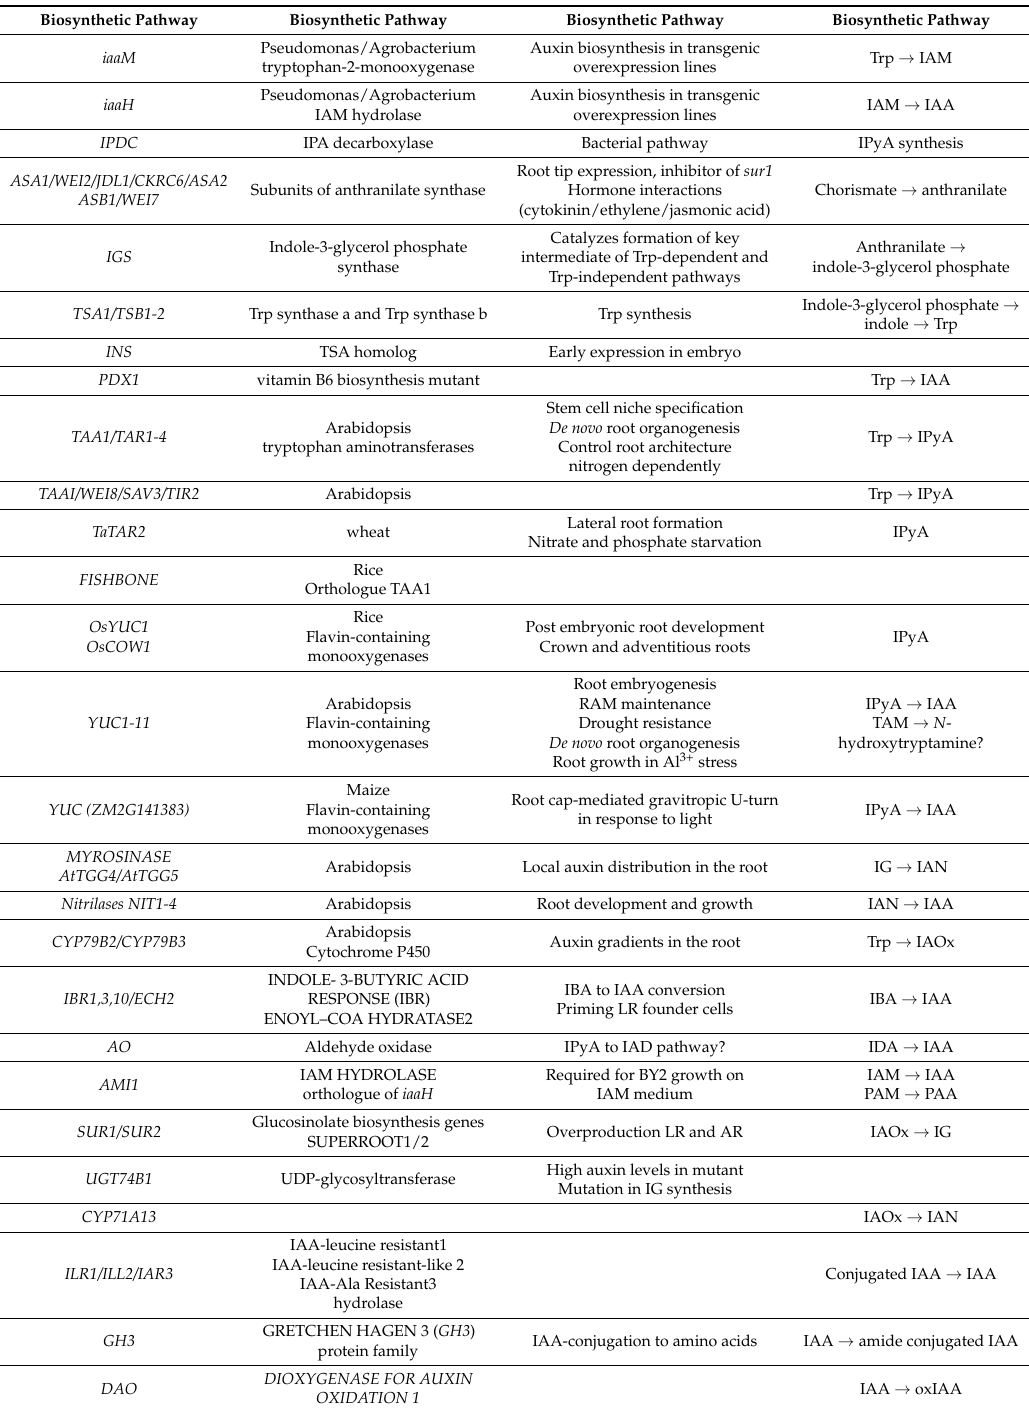
Table 1. Summary auxin biosynthetic genes in root